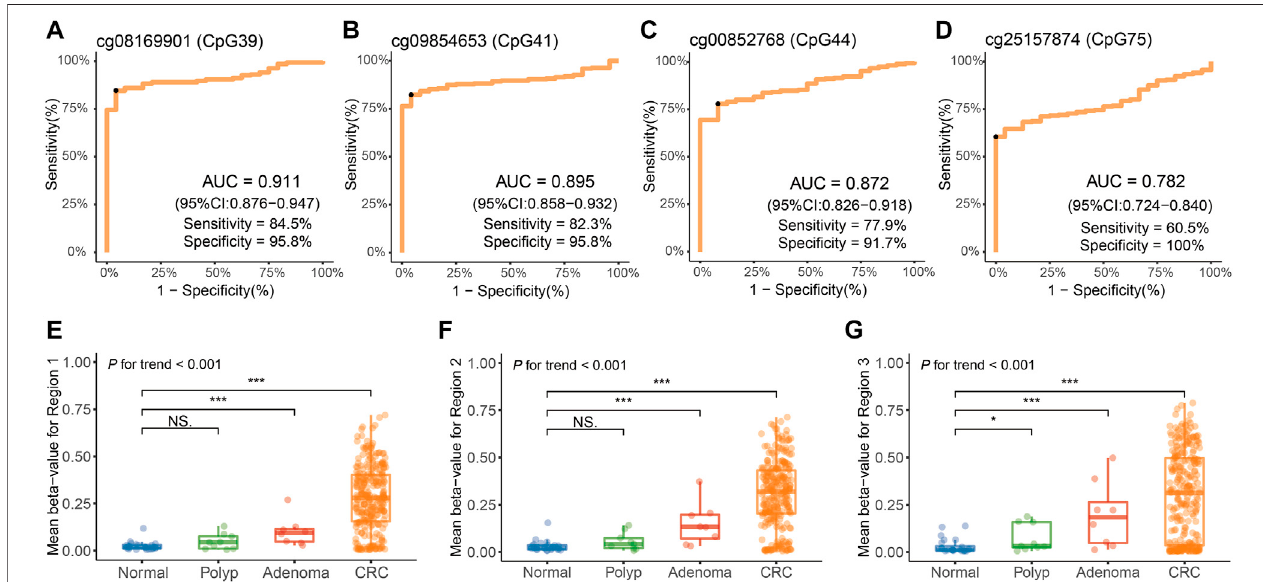
FIGURE 5 | Methylation analysis of the QKI promoter in the validation dataset. (A – D) Diagnostic performance of four target CpG sites for distinguishing CRC from adjacent normal tissues. The black point indicates the optimal cut-off value for each CpG. (E – G) Average methylation levels of three regions of the QKI promoter at different disease stages during neoplastic progression of colorectal cancer tissues. Symbols indicating statistical signi fi cance: NS, p > 0.05; *, p ≤ 0.05; **, p ≤ 0.01; ***, p ≤ 0.001; ****, p ≤ 0.0001.